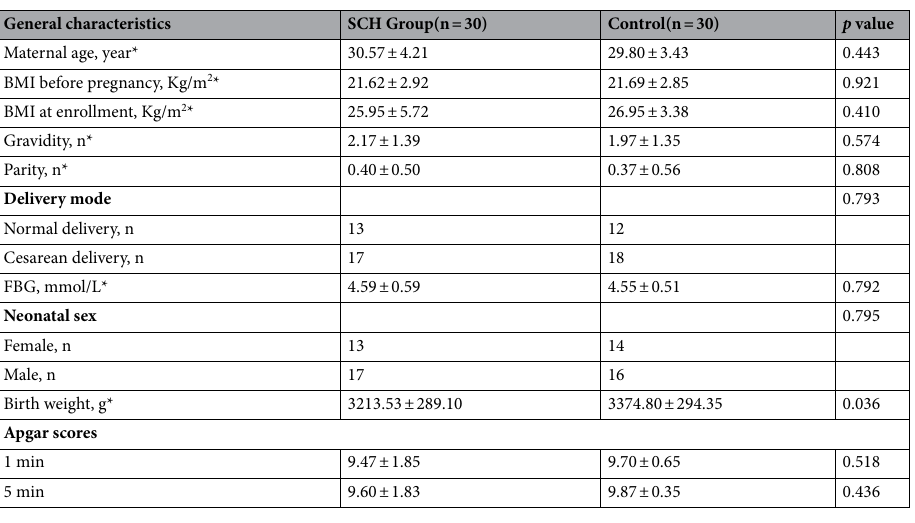
Table 1. Comparison of general clinical data and pregnancy outcomes between the SCH group and the control group. *Data are expressed as means ± standard deviation. p < 0.05 was considered statistically significant. Apgar scores: It is the scoring method made according to the child’s physical condition after birth, composed of five clinical components: Activity, Pulse, Grimace, Appearance, and Respiration. Each component receives 0, 1, or 2 points based on predetermined criteria, with a maximum score of